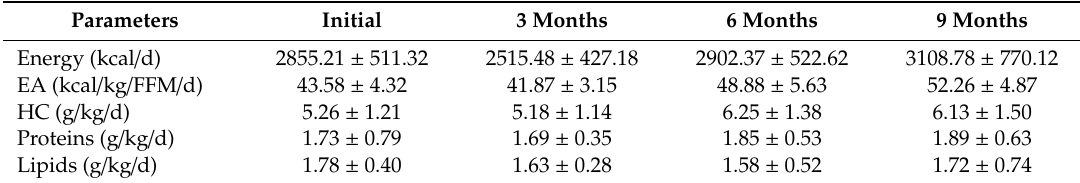
Table 3. Nutritional intake.